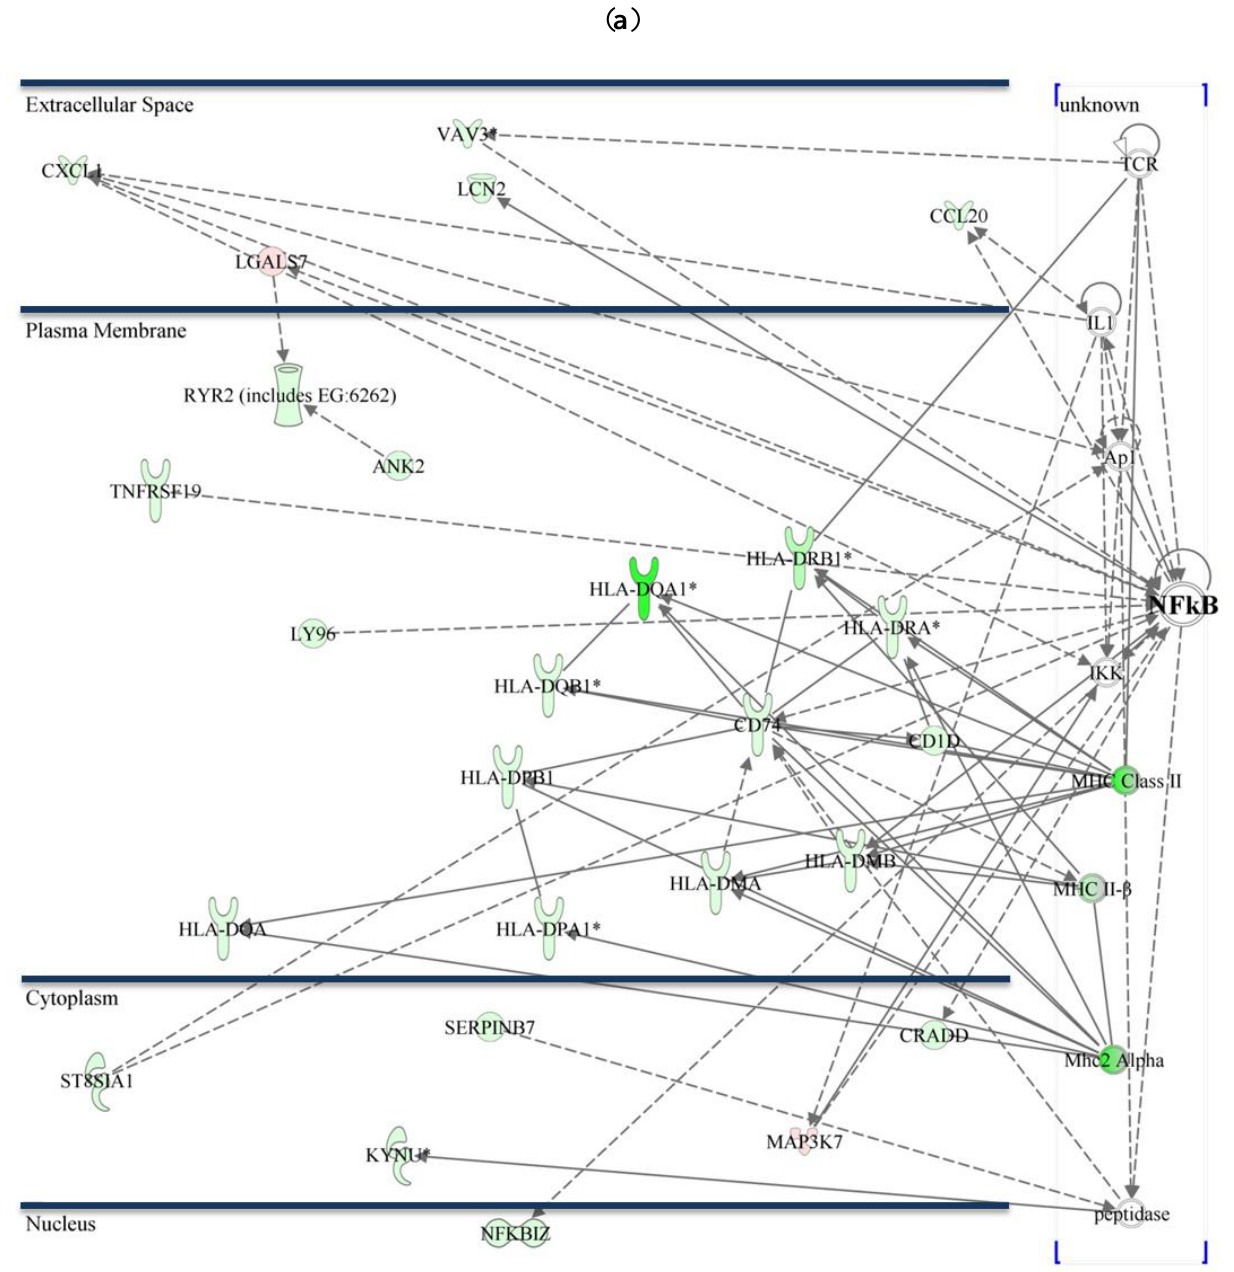
Figure 3. The NF-  B pathway and subcellular localization of differentially regulated genes connected with NF-  B: Within the NF-  B signaling pathway a total of 26 genes were differentially expressed in Group 1 ( a ); whereas 27 genes were shown to be regulated in Group 2 ( b ). ( Green marks indicate upregulation, red marks downregulation of the respective mRNA in 229R